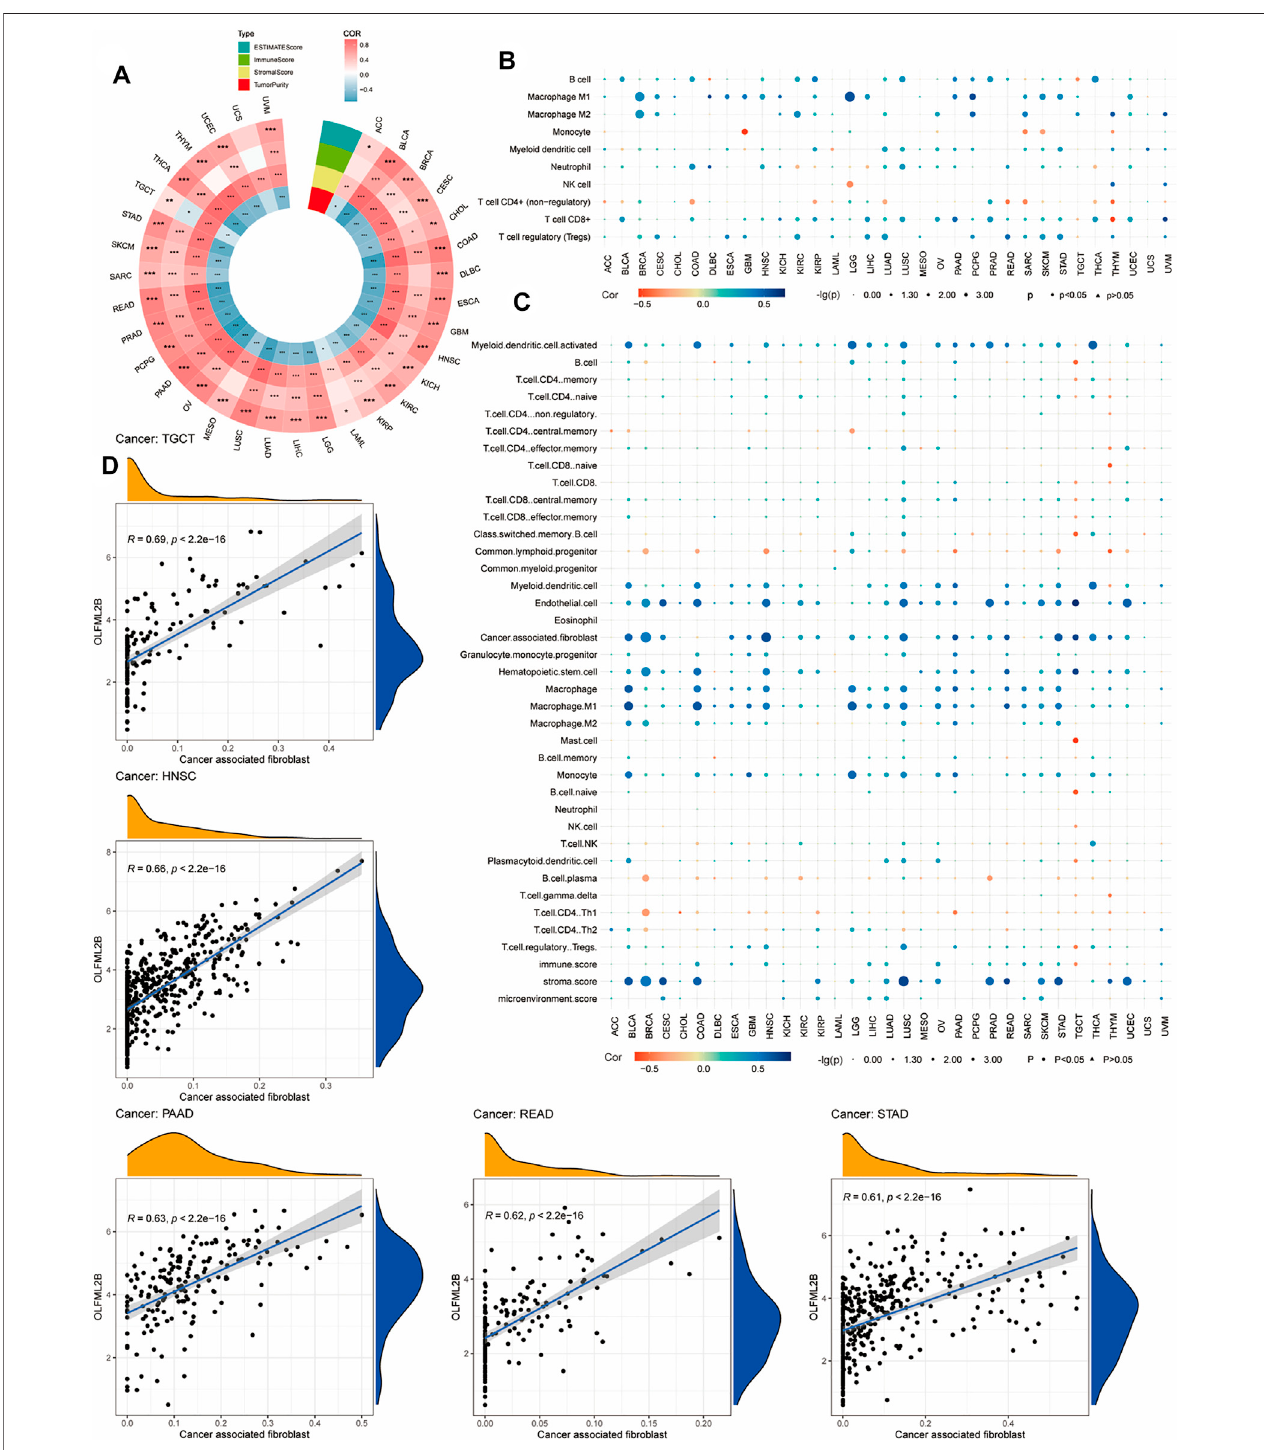
FIGURE 8 | Association between OLFML2B and TME and immune in fi ltration. (A) Association between OLFML2B expression and TME in pan-cancer. (B) Correlation between OLFML2B expression and immune in fi ltration based on QUANTISEQ algorithms. (C) Correlation between OLFML2B expression and immune in fi ltration based on XCELL algorithms. (D) Five tumors with the highest correlation between OLFML2B and CAFs.